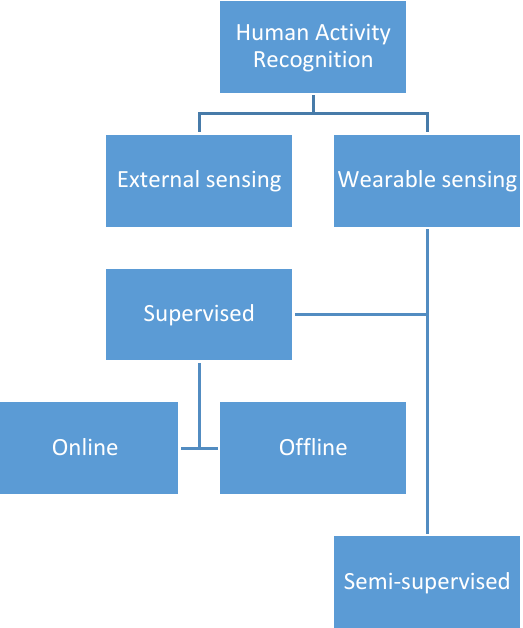
Figure 9. Approaches of human activity monitoring.